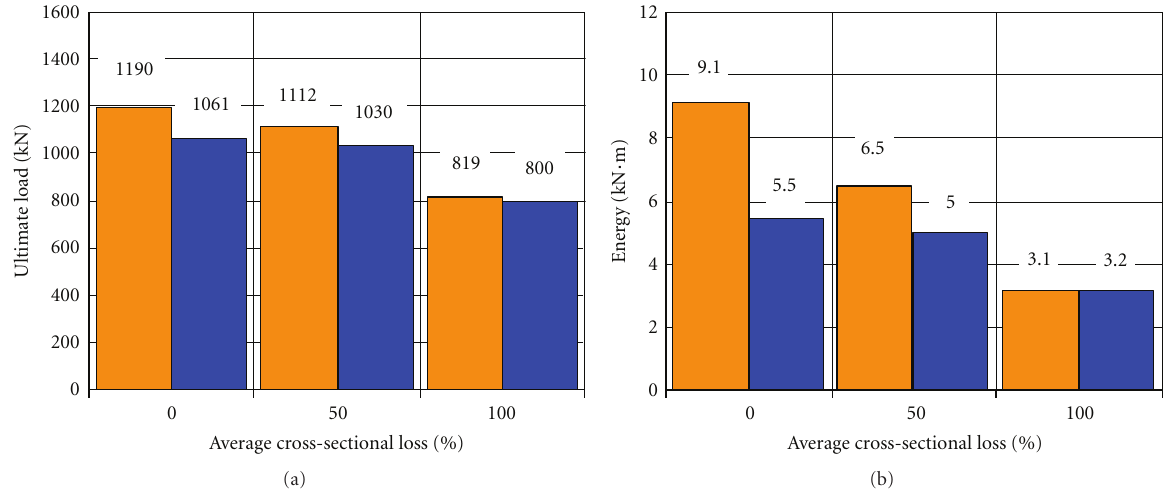
Figure 11: FE summary result for no-spall (yellow) and spall (blue) models: (a) ultimate load and (b)